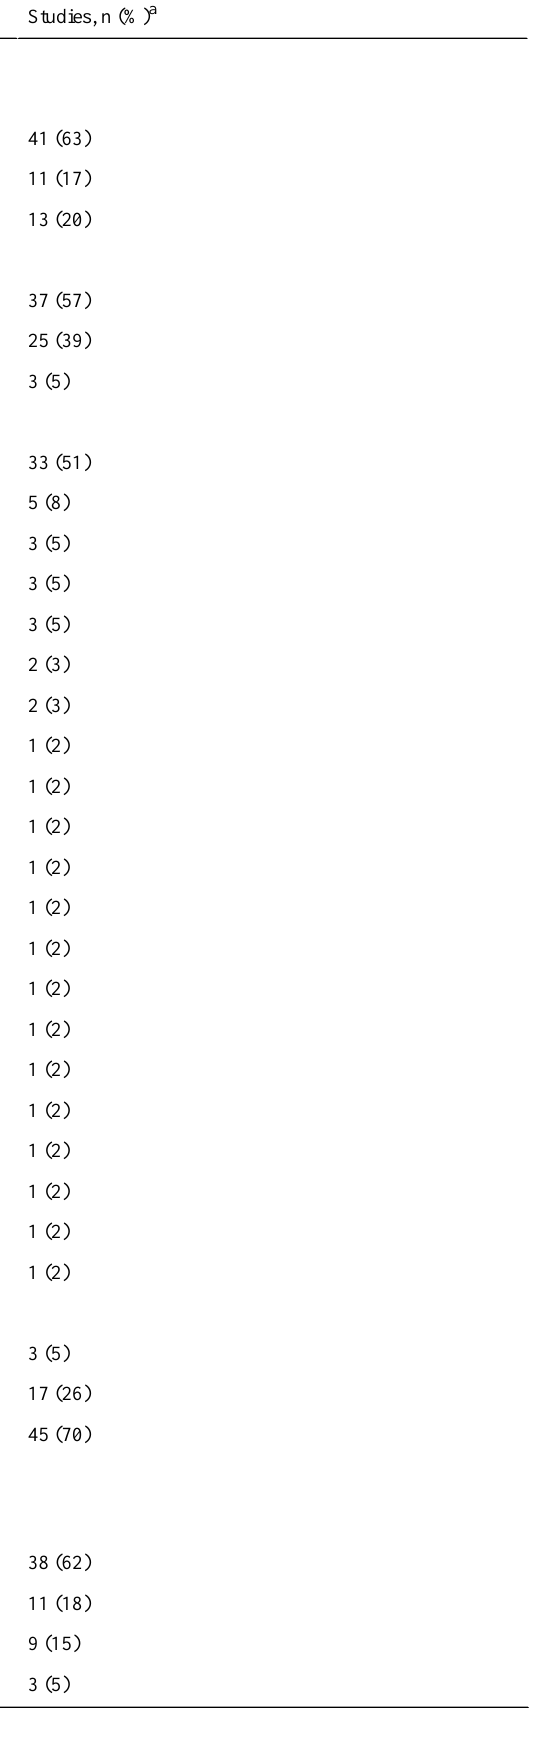
Table 1. Characteristics of the included studies